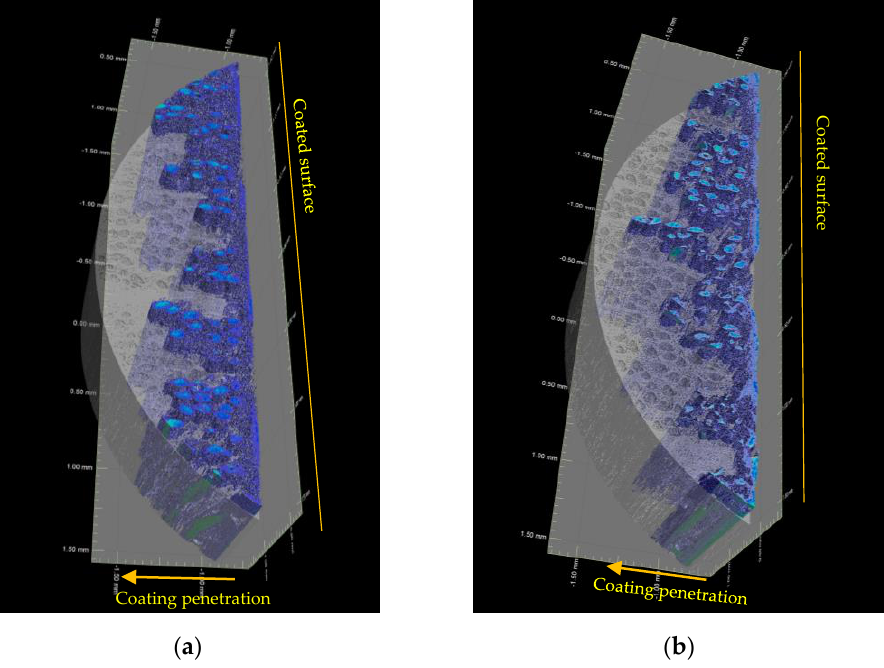
Figure 15. WH-coated veneer; ( a ) 3D visualization result using Cu target; ( b ) 3D visualization result using Mo target with Al filter.